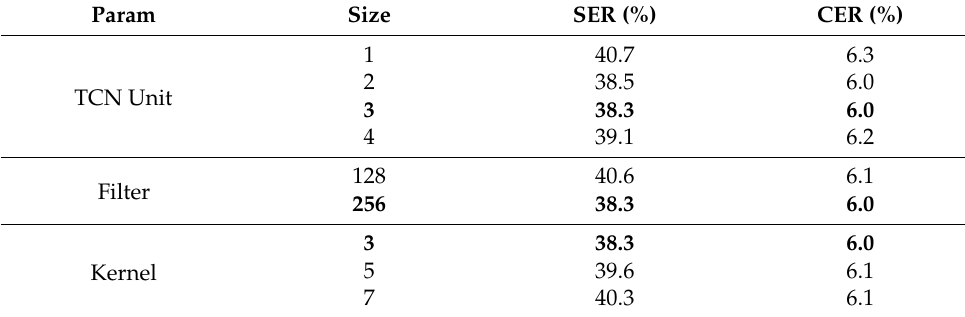
Table 6. Different hyperparameter settings for Conformer-TCN.